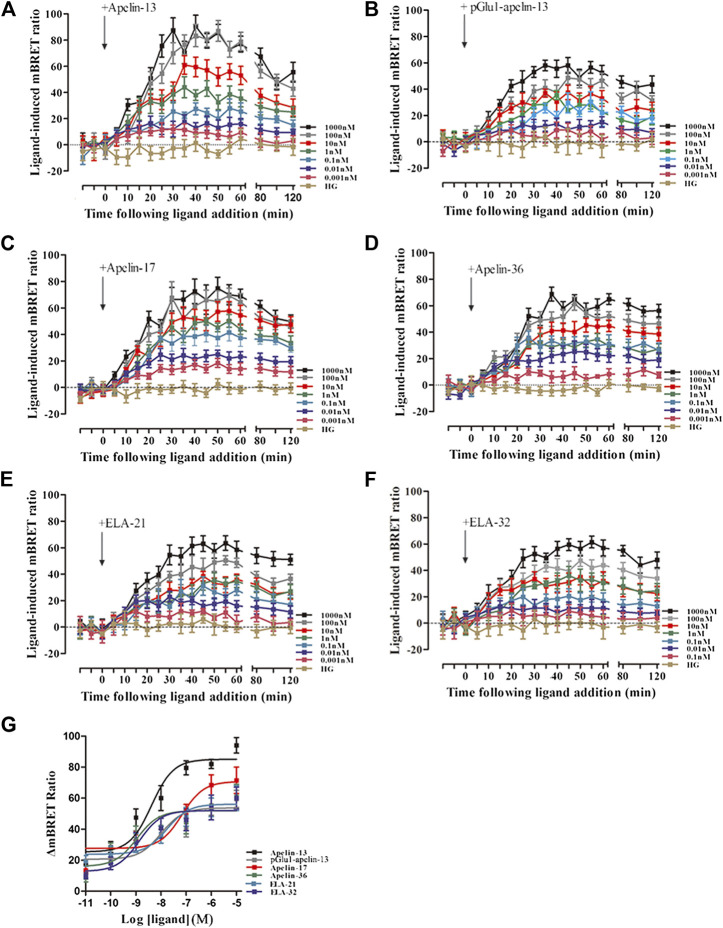
The time-response curve (A–F) and dose-response curve (G) of interactions between β-arrestin 2 and AP2 induced by APJ upon activation by the six agonists in different concentrations, obtained from real-time dynamic BRET determination. Control group (HG, Cells were stimulated with high glucose). p < 0.05 was considered as statistically significant. The BRET assay to measure the six peptide (0.001–1,000 nM) induced concentration-response curves of β-arrestin 2 and β2-adaptin recruitment to APJ at 30 min post-stimulation (G). The data represent means ± SEM of four independent experiments. Statistical analysis (Supplementary Table S8).